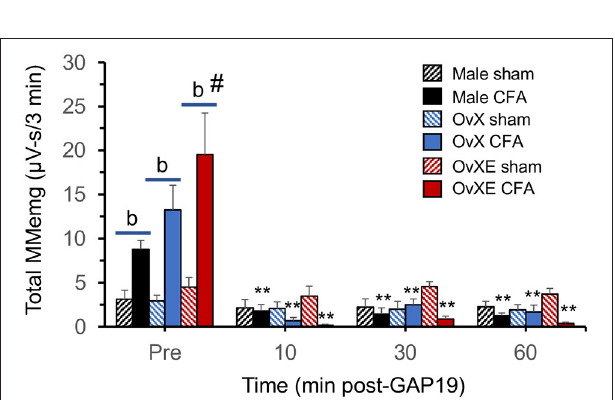
FIGURE 4 | Acute microinjection of GAP19 into the TG reduces the enhanced TMJ-evoked MMemg activity of 10 day CFA-treated males, OvX and OvXE females, while responses in sham rats were not affected. ** p < 0.01 vs. pre-injection response; b p < 0.01 sham vs. CFA groups; # p < 0.01 vs. all other groups. Sample size = 5 rats per